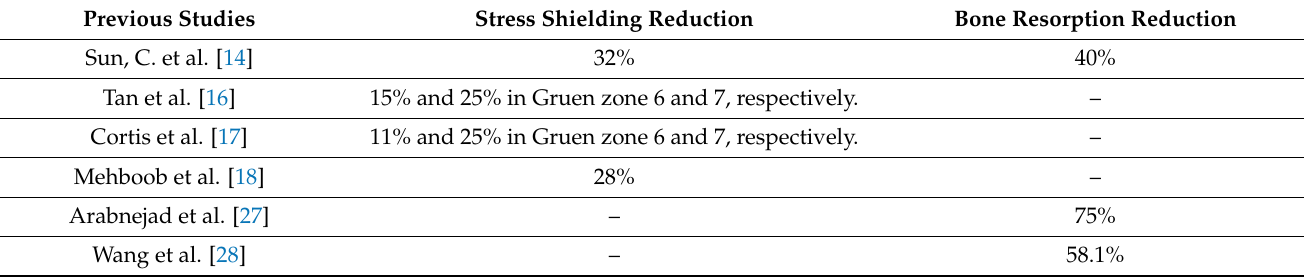
Table 1. Stress shielding and bone resorption reduction claimed in previous studies. En dash (–) line indicates an absence of